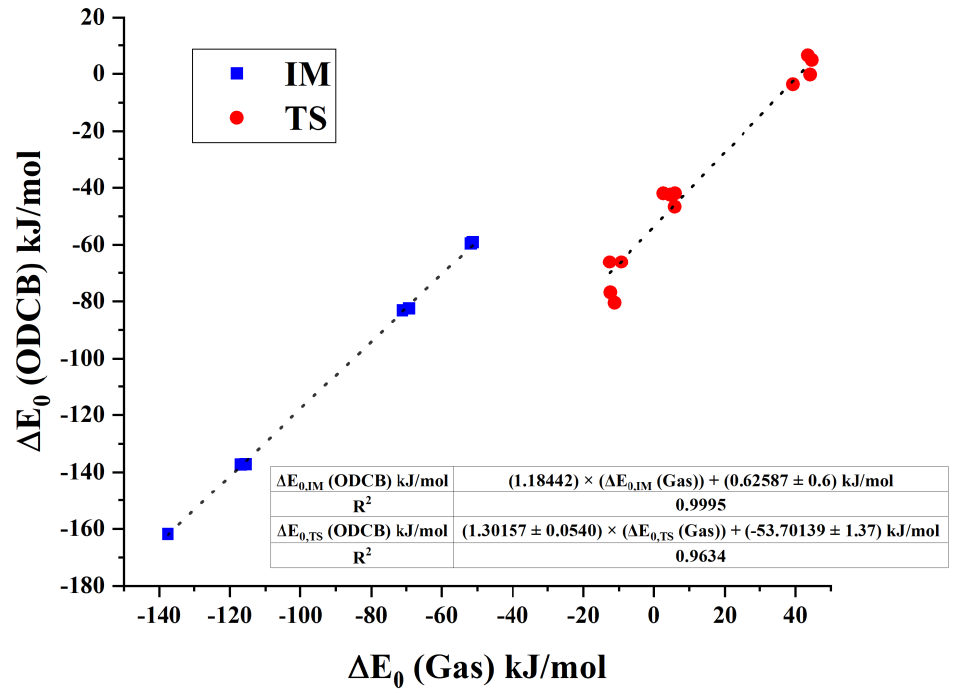
Figure 7. Comparison of intermediate and transition-state energies between gas phase and ODCB obtained at G3MP2B3. Fitted plots are marked in dotted lines.